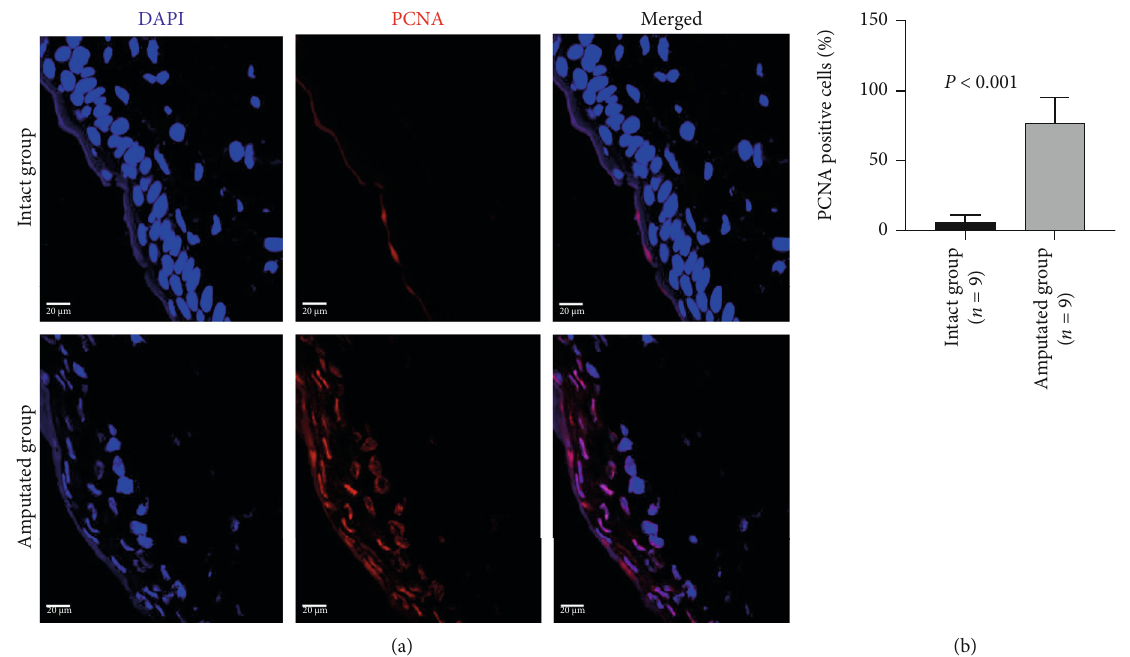
Figure 1: Immunohistochemical analysis on the PCNA-positive proliferating cells in tails 3 days after amputation. Representative images (a) and quantitative data (b) show the PCNA-positive cells in intact tails and amputated tails. Scale bar: 20 μ m.